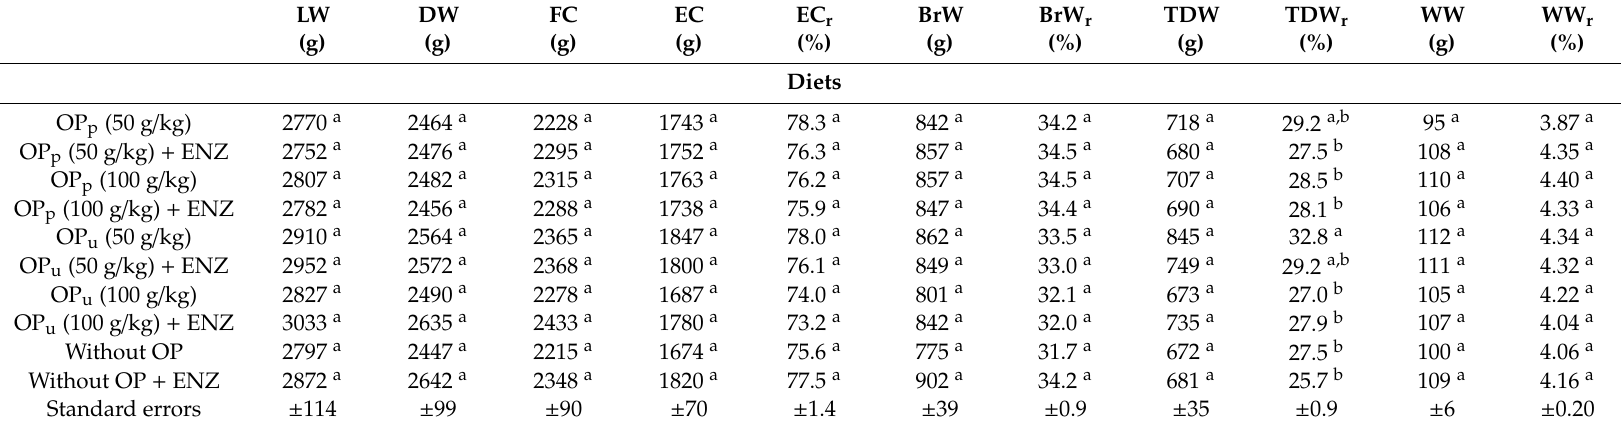
Table 4. Carcass traits of broilers fed diets containing di ff erent amounts of processed (OP p ) and unprocessed (OP u ) olive pulp, with and without enzyme (ENZ), in the period 1–6 weeks of